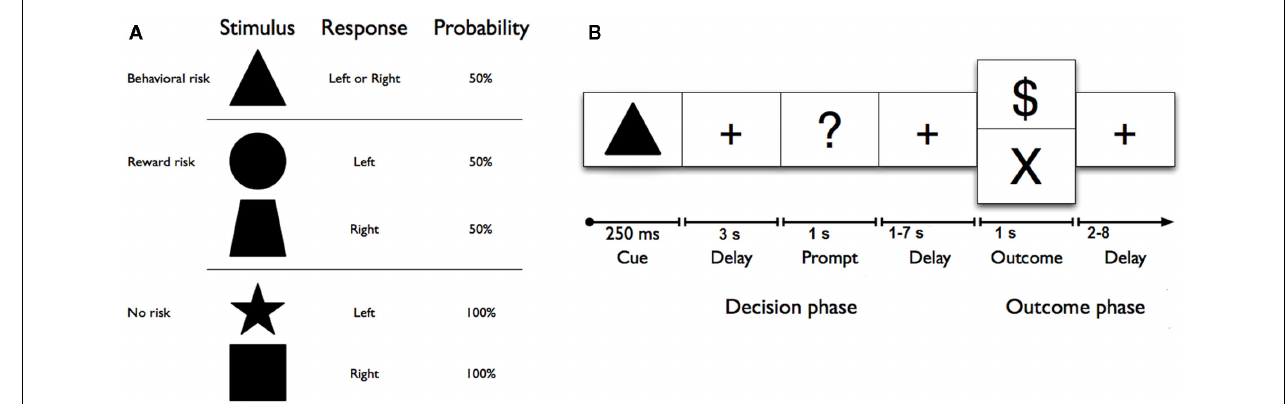
determined by both (a) a correct right or left button response and (b) a probabilistically determined reward.Thus, each trial began with a shape cue for 250ms in the center of the screen that indicated the trial type. After a 3-s delay, participants were prompted (i.e., “?”) for 1s to indicate their choice with a left or right button press with the second or third finger on the right hand. After a jittered delay (1, 3, 5, or 7s) where the fixation cross was presented, the trial outcome (reward: “$” for no and reward risk, reward: “$$”(not shown here) for behavioral risk, or no reward: “ × ”) was presented for 1s, and an updated tally of cumulative earnings was displayed in the lower portion of the screen. A fixation cross was displayed in the center of the screen during a jittered inter-trial interval (2, 4, 6, or 8s). Participants completed 150 trials on average, split evenly among six 6-min runs. Optimal performance could yield up to an additional $25 (e.g., $0.15 per correct response; for one dollar sign; $0.30 for two dollar